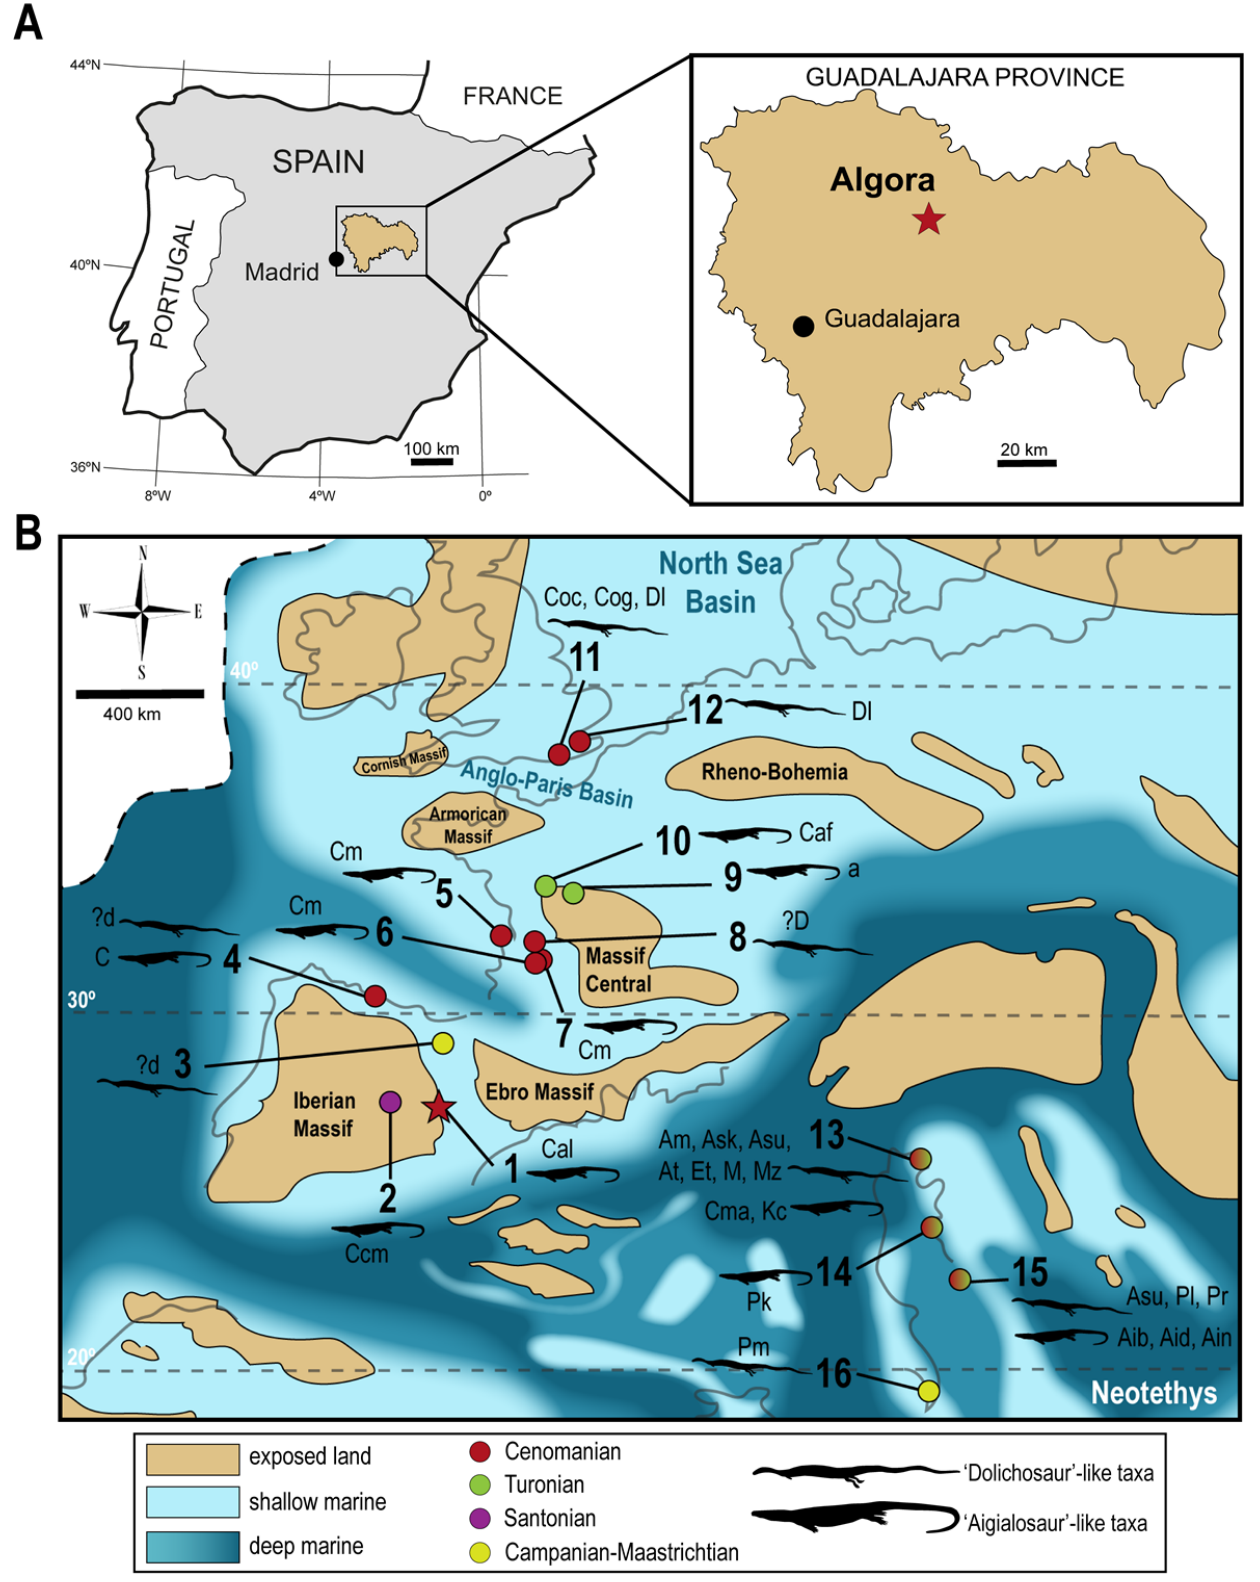
Figure 1. Type locality of Carentonosaurus algorensis sp. nov. (Algora, Guadalajara Province, Castilla- La Mancha Autonomous Community, Central Spain) ( A ), and late Cenomanian–early Turonian paleogeographical map (modified from Janetschke and Wilmsen [19]), showing the distribution